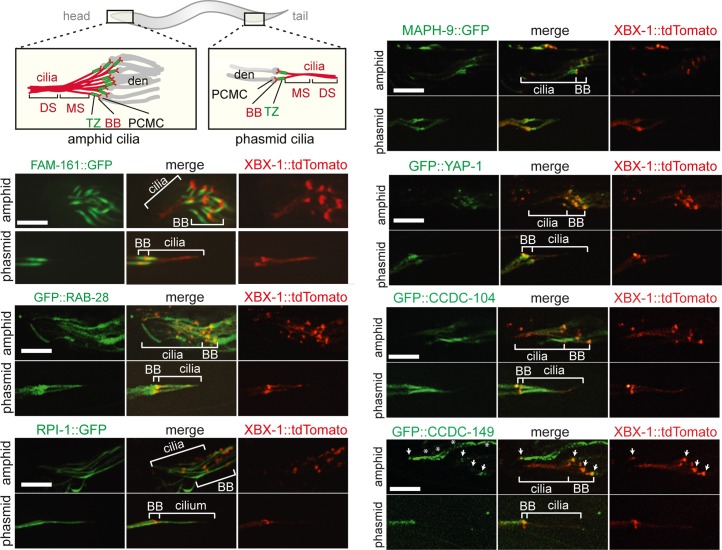
Candidate cilium-associated proteins localise to ciliary structures Representative images of amphid (head) and phasmid (tail) cilia from N2 wild type worms co-expressing GFP-tagged ‘translational’ reporters for candidate ciliary genes and tdTomato-tagged XBX-1 (IFT protein that localises to the ciliary base and axoneme).All reporters driven by the endogenous gene promoter, except for YAP-1 and RAB-28, where a bbs-8 gene promoter sequence was used (see Fig 3A for a GFP::RAB-28 reporter driven by the endogenous promoter). GFP tags are on the N- or C-terminus, as indicated above the panels. PCMC (periciliary membrane compartment); distal dendrite (den) swelling enriched for endocytosis-associated proteins and vesicles that regulate ciliary membrane homeostasis [19]. The transition zone (TZ) extends from basal body (BB) and functions as a ciliary gate that regulates protein entry and exit to and from cilia [6]. Middle (MS) and distal (DS) segments; characterised by a circular array of 9 doublet (A and B tubules) and 9 singlet (A tubules) microtubules, respectively (not shown). Note that for GFP::CCDC-149, signals are observed at the amphid/phasmid basal bodies (arrows) and as punctae (asterisks) along the dendrite of the OLQ ciliated neuron running parallel to the amphid neurons. Scale bars; 5 μm.